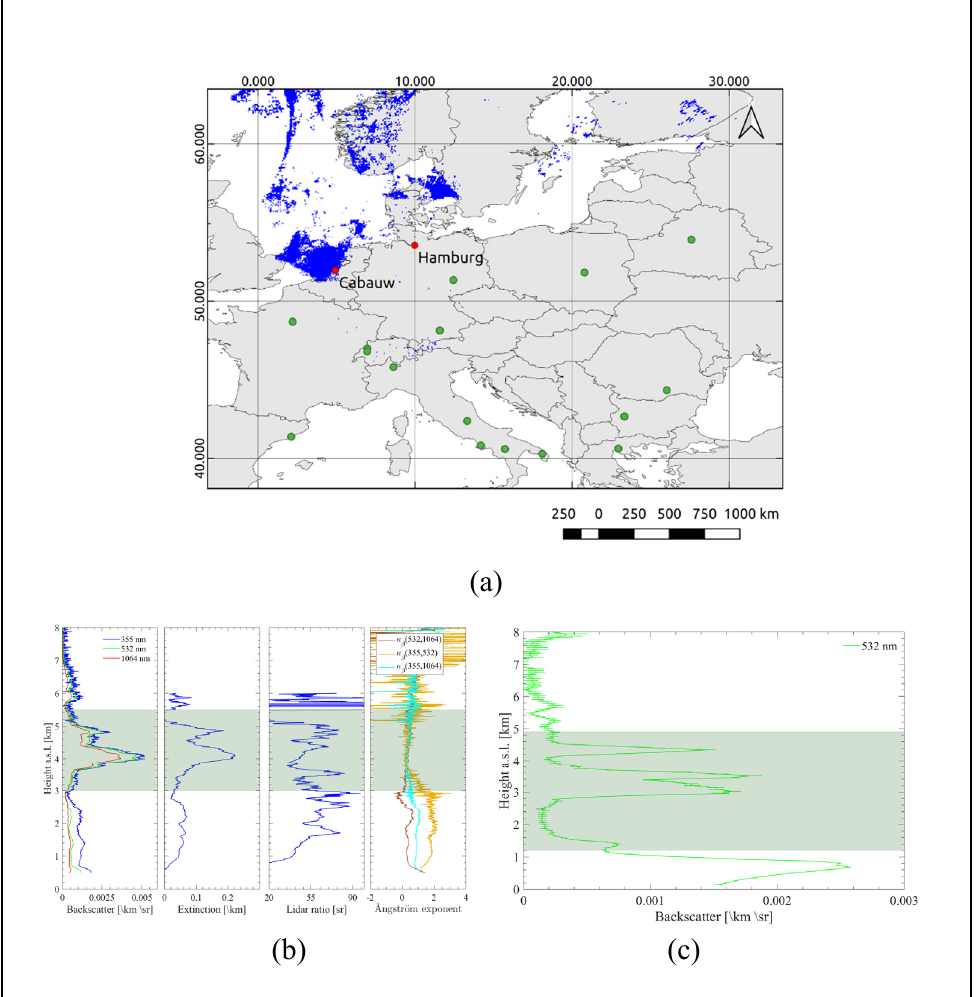
Figure 5. ( a ) Tailored RST ASH products of May 17 at 18:00 UTC and EARLINET measurement stations (in red) revealing the presence of ash, in green sites where no information was available. ( b ) Cabauw EARLINET aerosol backscatter coefficient, extinction coefficient, lidar ratio, and Ångström exponent profiles acquired the same day between 17:30–18:30 UTC. The green zone indicates the ash-affected portion of the profile. ( c ) Hamburg EARLINET aerosol backscatter coefficient acquired the same day between 17:30–18:30 UTC.